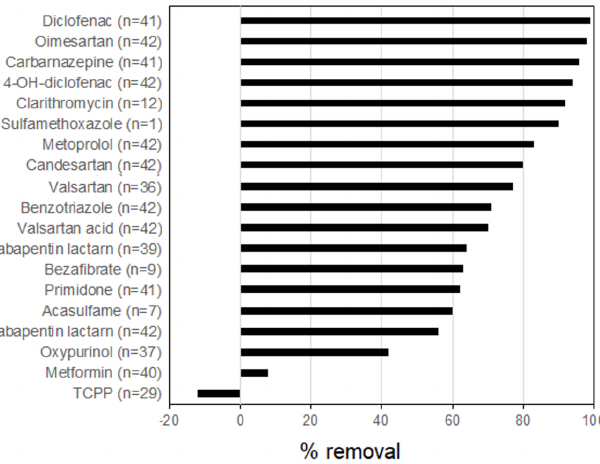
Figure 4. Average percentage removal of 19 monitored PPCPs during ozone treatment of wastewater in a pilot plant study ((n is the number of data points) (redrawn from Sauter et al., [34]).